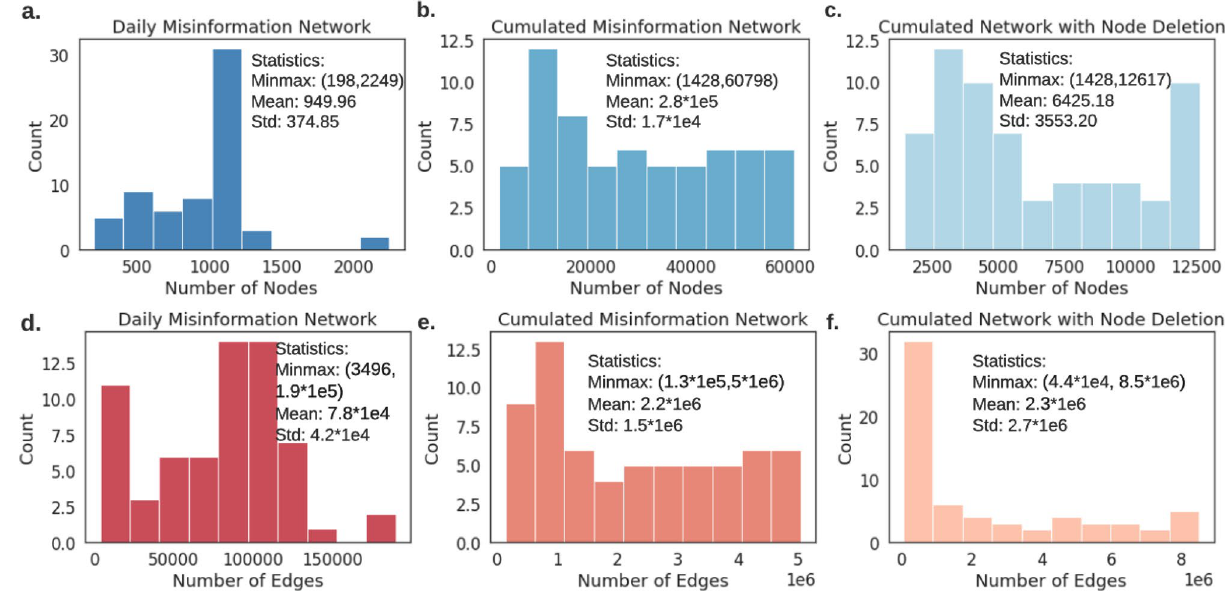
Figure 8. Statistics comparison between networks constructed by formulation I–III. ( a–c ) Node number comparison. ( d–f ) Edge number comparison. We can see that the cumulated misinformation networks (with and without node deletion mechanism) are larger in scale and contain much more nodes and edges compared to daily misinformation